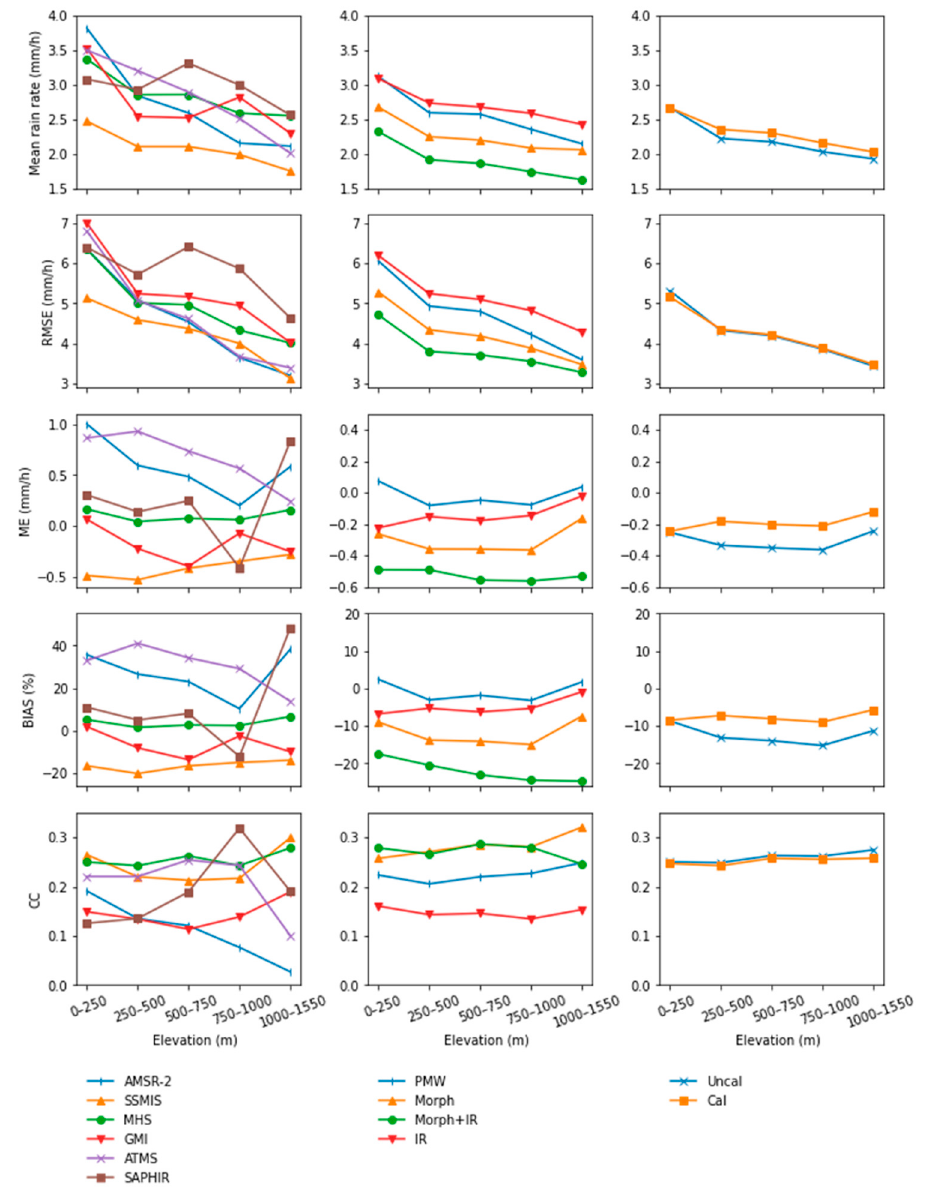
Figure 7. Mean value and four continuous indices, Root-Mean-Square Error (RMSE), Mean Error (ME), BIAS, and Correlation Coe ffi cient (CC), of the hit data of 12 IMERG estimates according to di ff erent elevation bands. The left, middle, and right columns indicate the IMERG estimates for the first, second, and third levels of evaluations. It is noted that the scales of ME and BIAS in the left figures are di ff erent from their values in the middle and right figures, since the di ff erent systematic performances of the evaluated